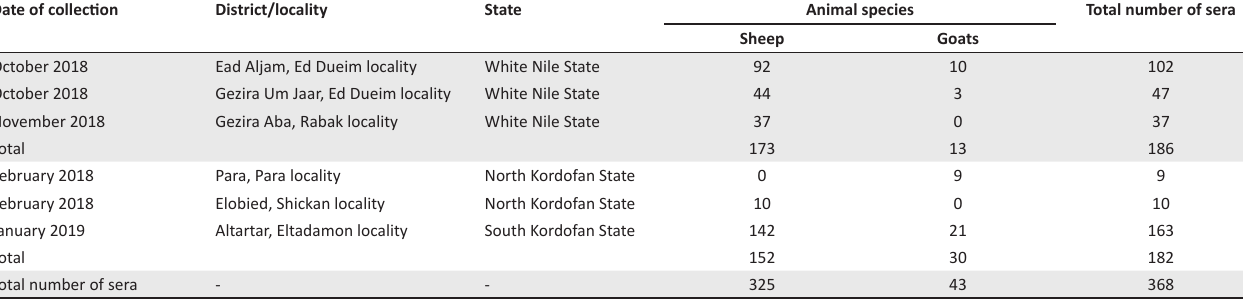
FIGURE 2: Districts and localities of serological investigations of peste des petits ruminants in White Nile, North Kordofan and South Kordofan States. State capitals are presented. TABLE 1: Sheep and goat sera collected from White Nile and Kordofan States in Sudan during 2018–2019.